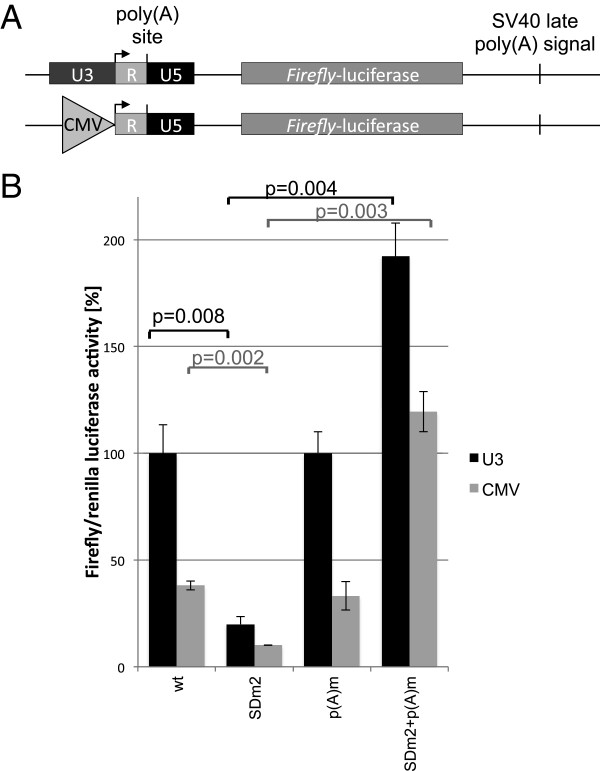
Regulation of polyadenylation is promoter-independent. Exchange of FV U3-promoter with the CMV-I.E. promoter has no influence on the regulation of polyadenylation. (A) Plasmid schemas are indicated above. (B) Bars represent the mean value of three independent transfections, and the error bars represent the standard deviations. The significance of the reduction by the SDm2 mutation or increase by SDm2+p(A)m was calculated by paired two-sample t-test. p-values are indicated.